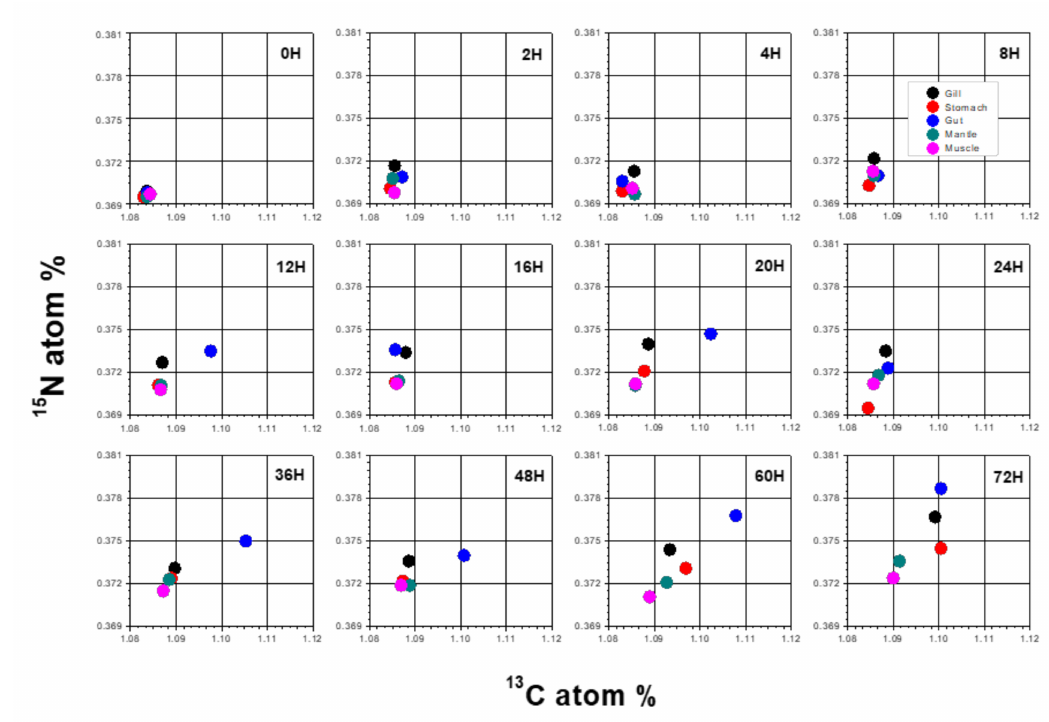
Figure 5. Timely variation of atom% of 13 C and 15 N in various tissues of Unio douglasiae in experimental chambers over 72 h. Each value is the average of three subsamples (Supplement-2).